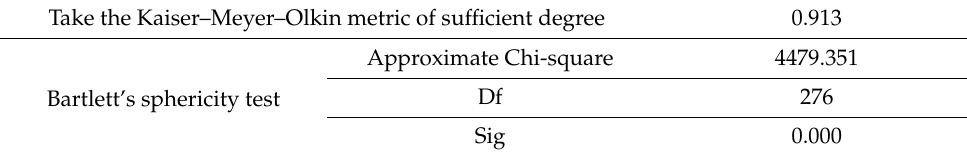
Table 6. KMO and Bartlett’s test.